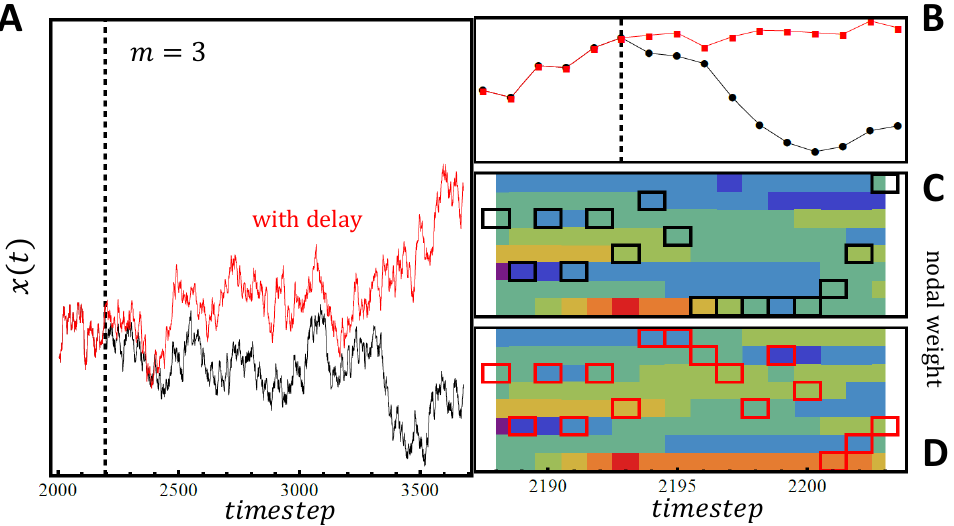
Figure 5. ( A ) System output (e.g., price) for the GCMG (black line—no delay) and the DGCMG (red line—delay τ = 2 introduced at timestep t 0 = 2193). The population of components (i.e., agents) has size N = 101: each inputs the system-wide reported information (see Figure 2) and can output an action; ( B ) Panel A magnified around t 0 , the time of the delay implementation; ( C ) Dynamics of GCMG shown in terms of the nodal weights (see main text); ( D ) Corresponding dynamics of DGCMG. In ( C , D ), there are 2 m nodal weights at each timestep, shown on the y -axis, corresponding to the 2 m possible nodes in the de Bruijn graph. The highest weight is red while lowest is